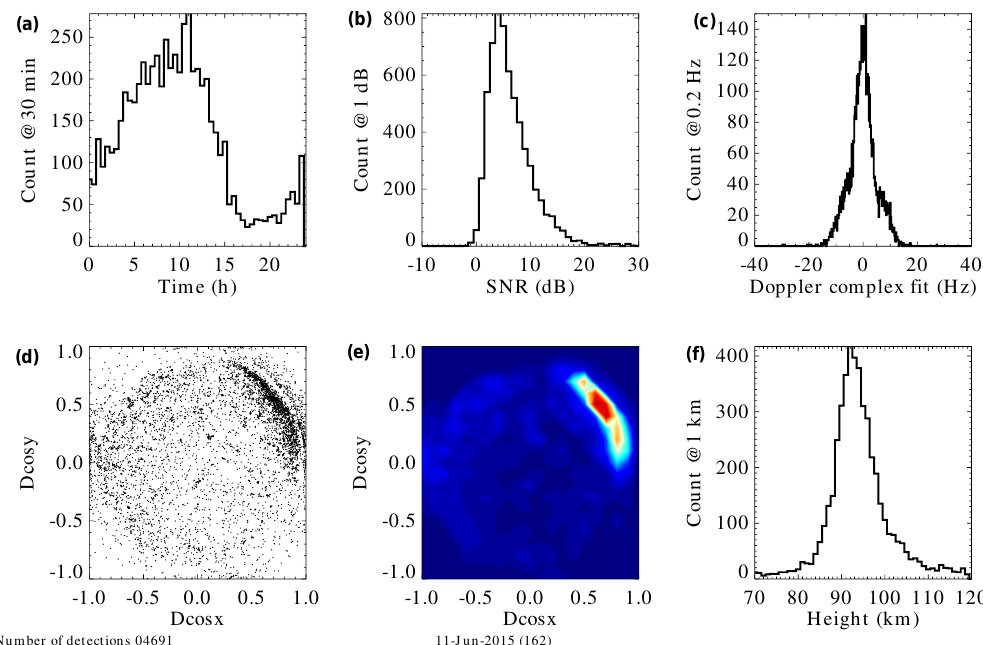
Figure 4. Summary results from coded CW specular meteor radar experiment for 24h taken on 11 June 2015. (a) Count as function of day, (b) SNR histogram, (c) Doppler velocity histogram, (d) echo location, (e) echo location bivariate histogram, and (f) altitude distribution.